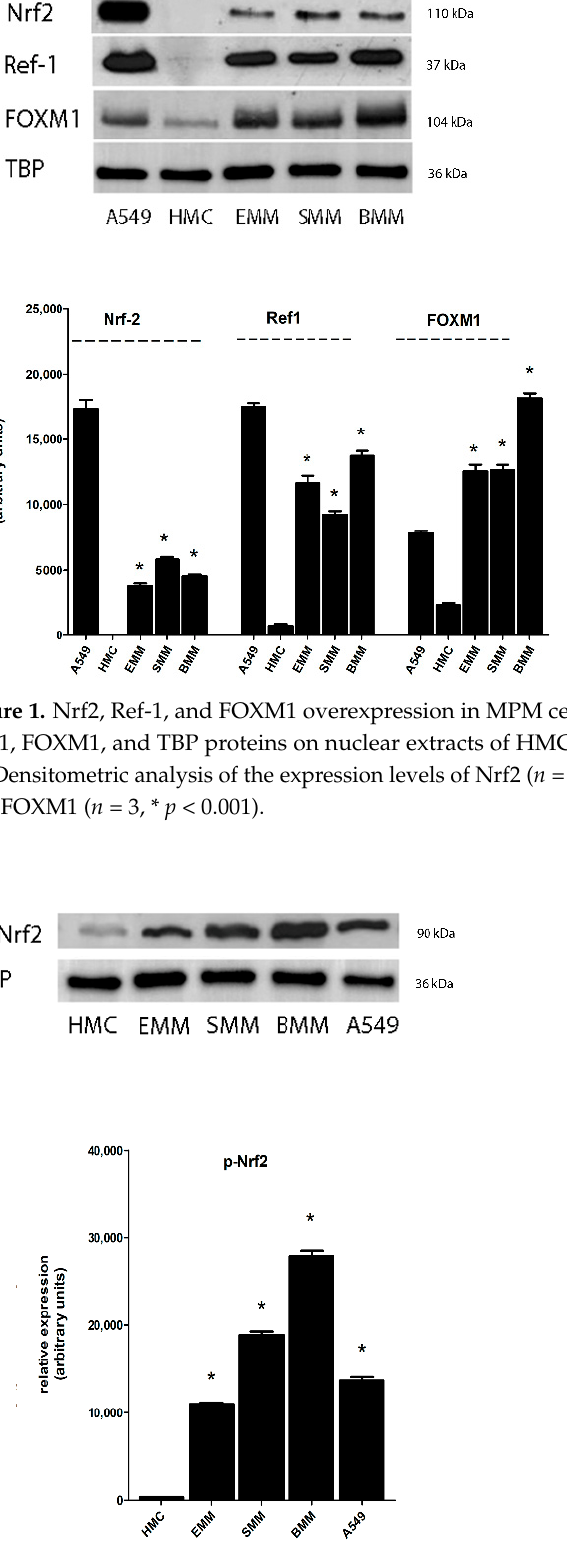
Figure 2. Phospho-Nrf2 overexpression in MPM cells. ( A ) Western Blot analysis of phosphorylated Nrf2 (p-Nrf2) and TBP proteins on nuclear extracts of HMC, EMM, SMM, BMM, and A549 cells. ( B ) Densitometric analysis of the relative expression of p-Nrf2 ( n = 3, * p <